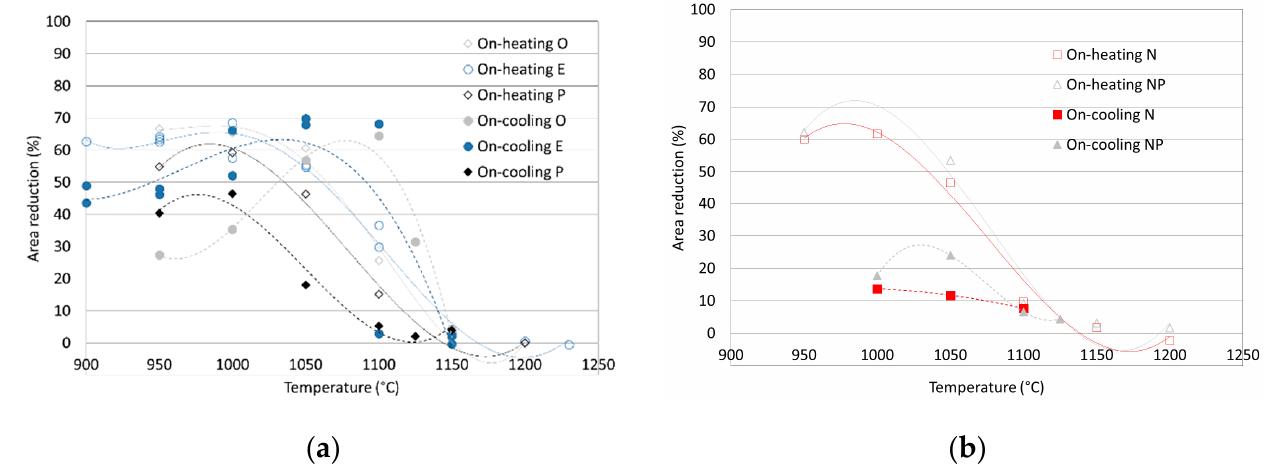
Figure 7. On-heating and on-cooling curves in terms of area reduction percentage and testing temperature for moulds E, O, and P ( a ), and N and NP ( b ). Table 6. Weldability parameters obtained from hot ductility tests.